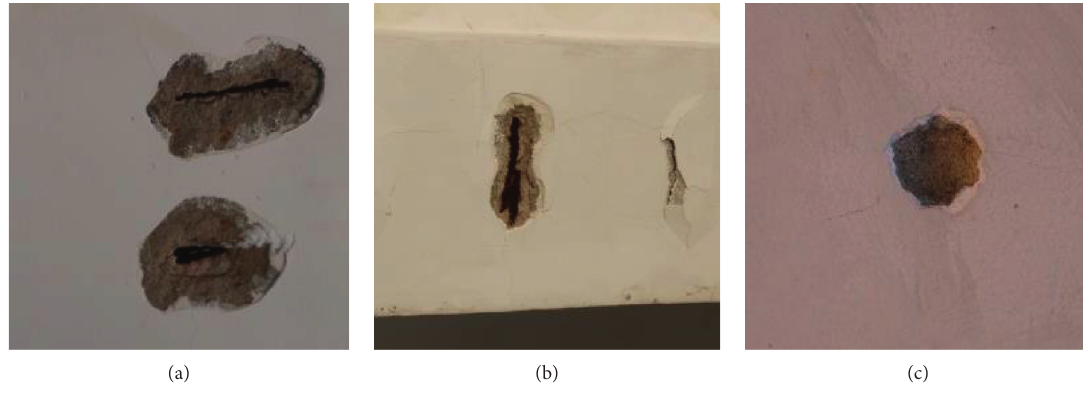
Figure 1: Spall objects on (a) ceiling, (b) beam, and (c) wall